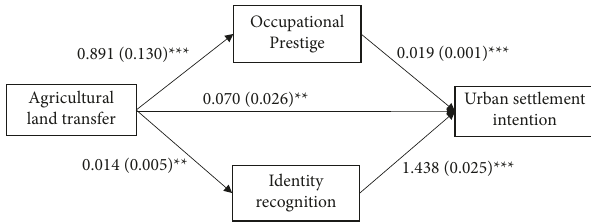
Figure 2: Research model path analysis